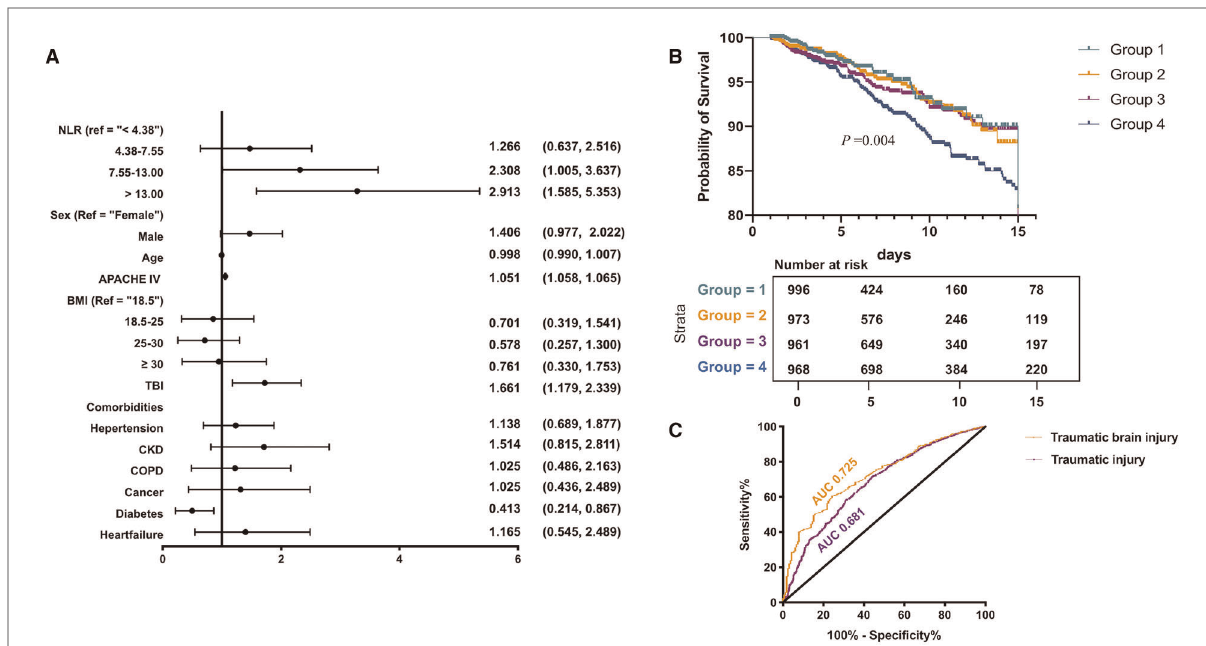
FIGURE 2 Multivariate regression model and adjusted survival curves in traumatic patients: ( A ) multivariate logistic regression model was used to show that the higher NLR was an independent risk factor of ICU mortality for traumatic patients, ( B ) the adjusted cumulative survival curve indicated the marked survival disadvantage in group 4 compared with that in group 1 ( P =0.004), and ( C ) ROC curve analysis indicated that the NLR in predicting ICU mortality in patients with TBI was higher than that in patients with trauma